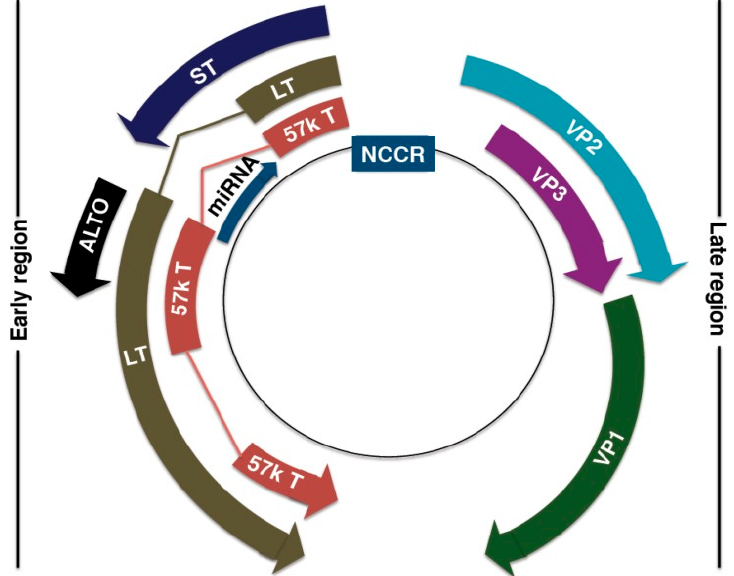
Figure 3. Merkel Cell Polyomavirus (MCPyV) genome organization. Non-coding control region (NCCR): bipartite origin of replication. Early gene region: Large T antigen (LT), small T antigen (ST), 57kT antigen (57kT), alternative T antigen open reading frame (ALTO), microRNA (miRNA). Late gene region: capsid proteins (VP1-3). Reproduced with permission from Stakaityt ė , G., Merkel Cell Polyomavirus: Molecular Insights into the Most Recently Discovered Human Tumour Virus; published by Cancers , 2014.